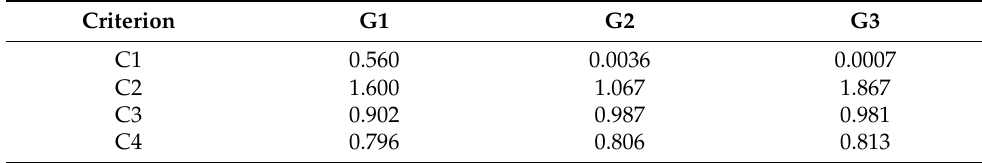
Table 7. Dimensionless values of the sampling data.